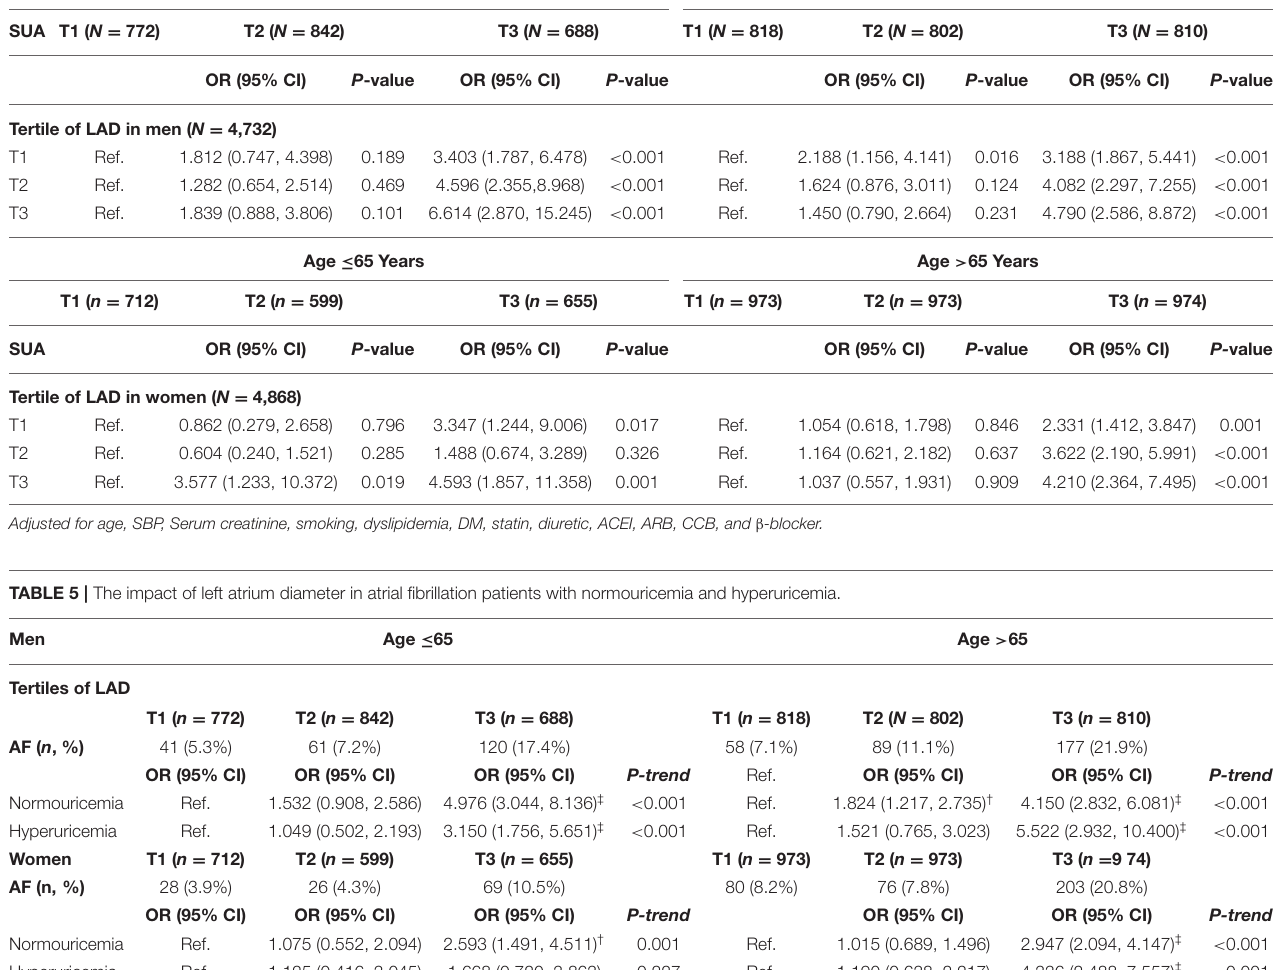
TABLE 4 | The prevalence of AF according to baseline SUA tertile grouped by LAD in men and women. Age ≤ 65 Years Age > 65 Years SUA T1 ( N = 772) Tertile of LAD in men ( N = 4,732)